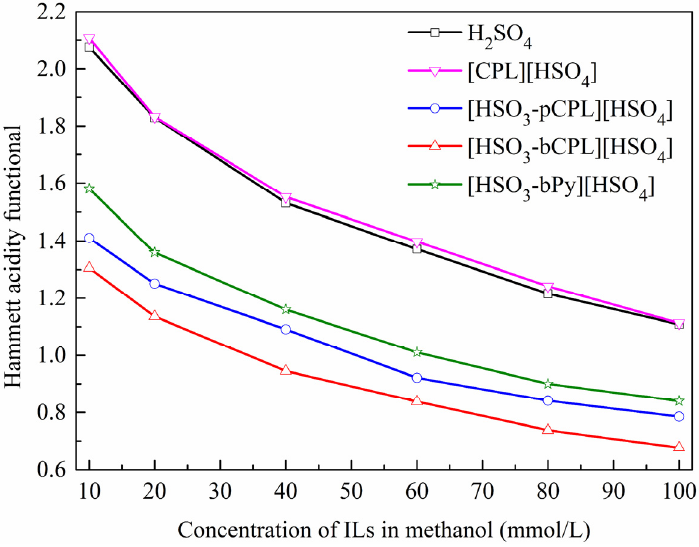
Figure 2. Hammett acidity functional (H 0 ) of the ILs in methanol with 4 ‐ nitroaniline as indicator.